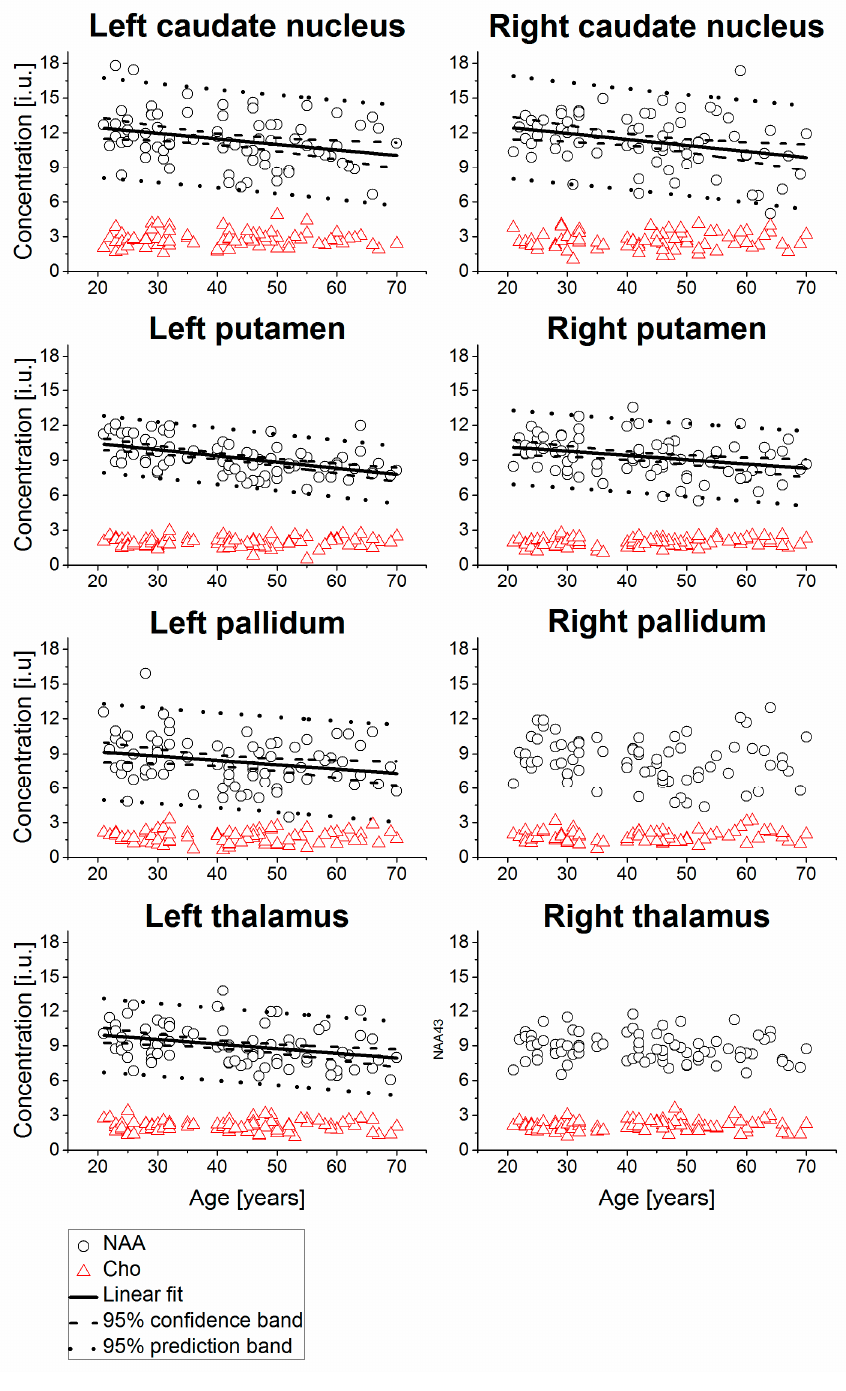
Figure 3. Relative concentrations of NAA and Cho from bilateral caudate nucleus, putamen, pallidum, and thalamus shown as a function of age, including linear fits with 95% prediction interval and 95% confidence interval for statistically significant cases ( p < 0.05). The values are presented in institutional units (i.u.) normalized using the signal from tissue water.